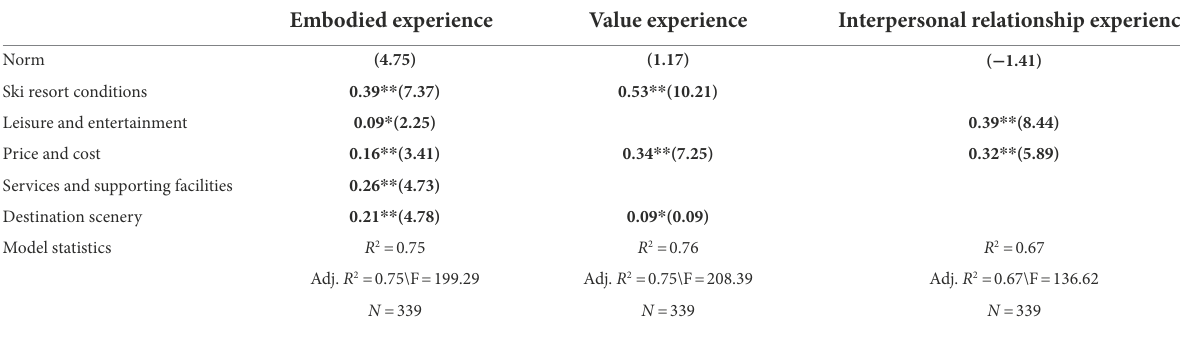
TABLE 6 Linear regression model.